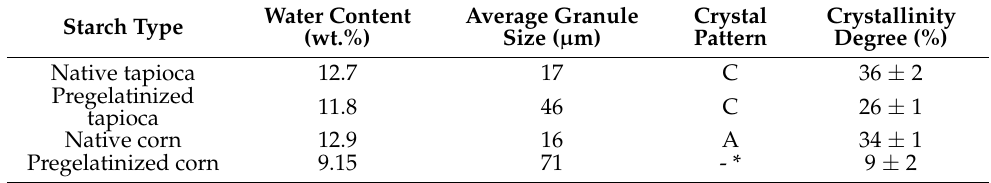
Table 3. Water content, average starch granule size, crystallinity degree and pattern of the four starch powders investigated.